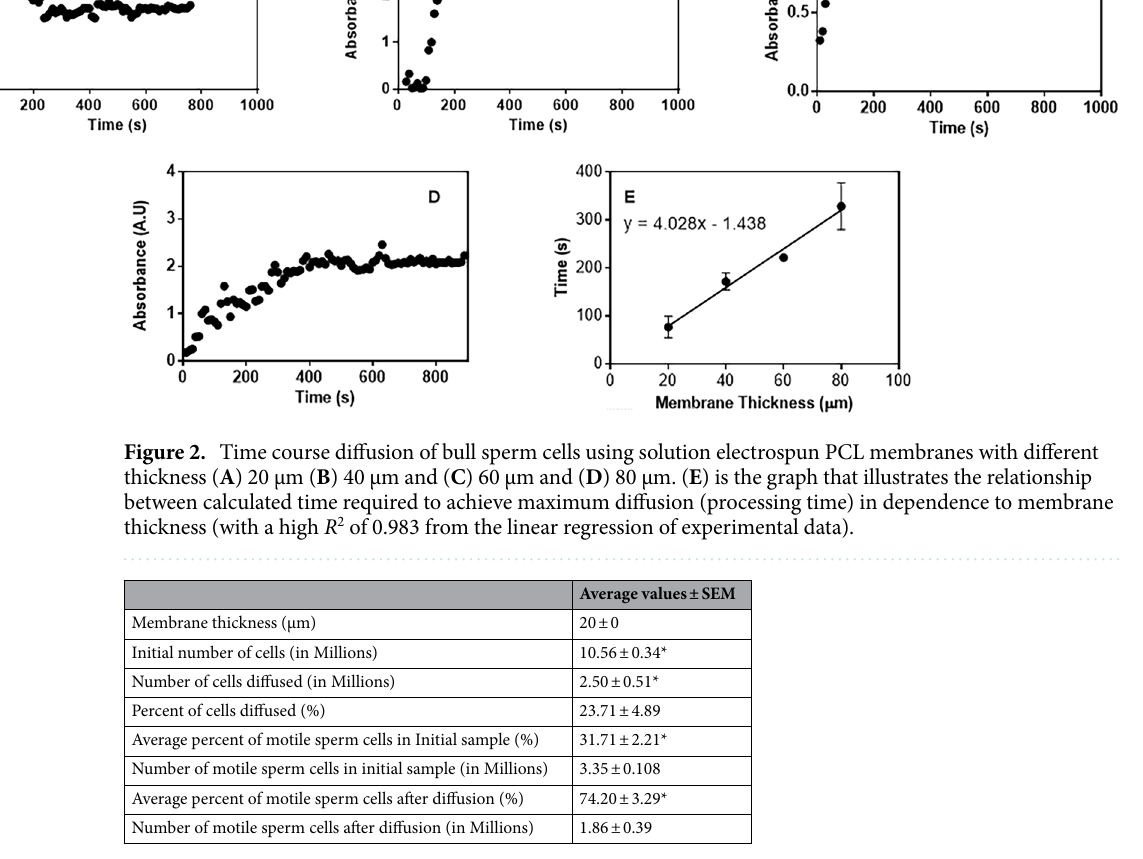
Table 1. Summary of data obtained from initial experiments with N = 6. The SEM for the other values were calculated by propagating the errors obtained from data with *.